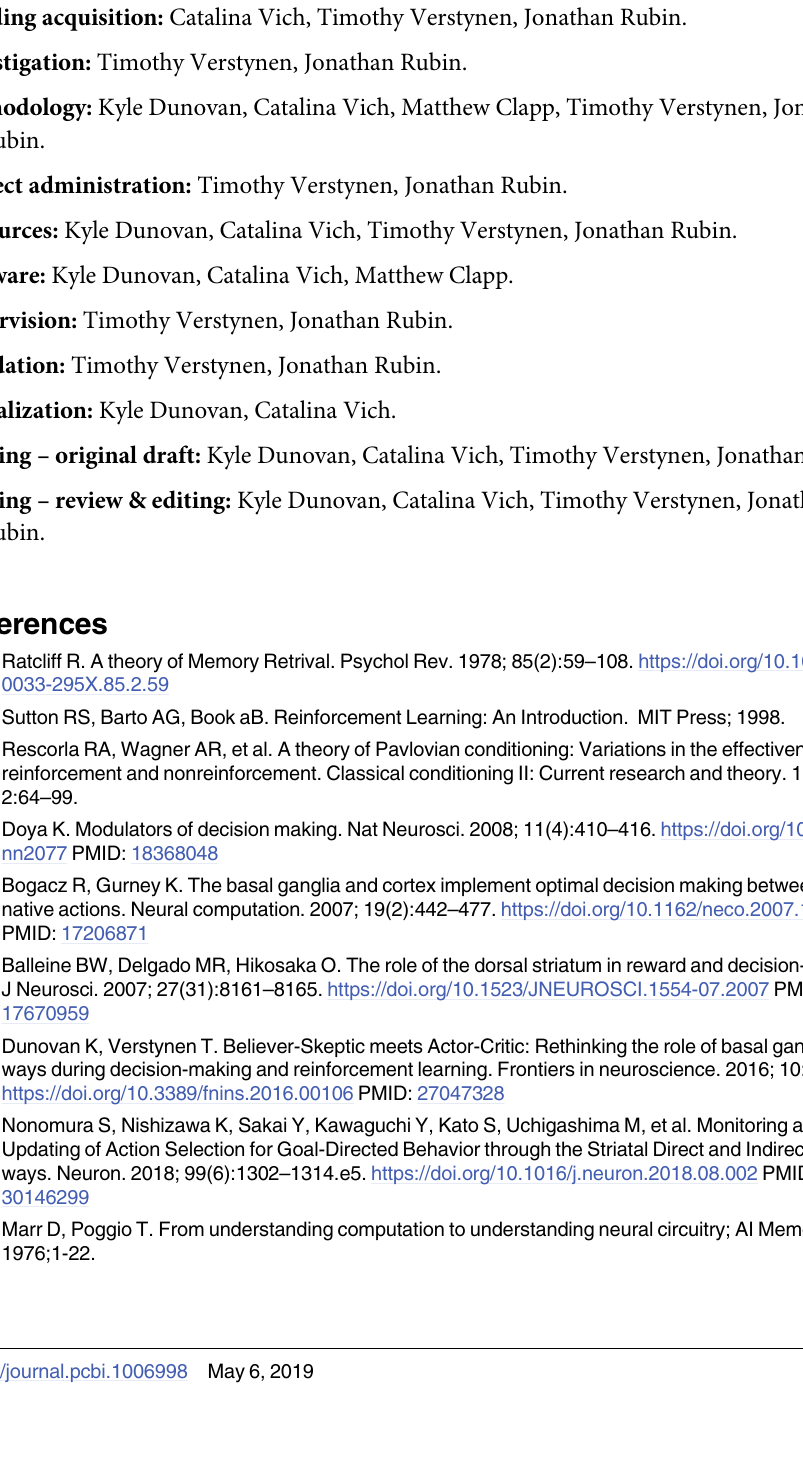
reward conditions. Logistic (left, center-left) and linear (right, center-right) regression predic- tions for each condition are shown as lines. B. The same data as shown in panel A from multi- ple (N = 15) randomly sampled CBGT